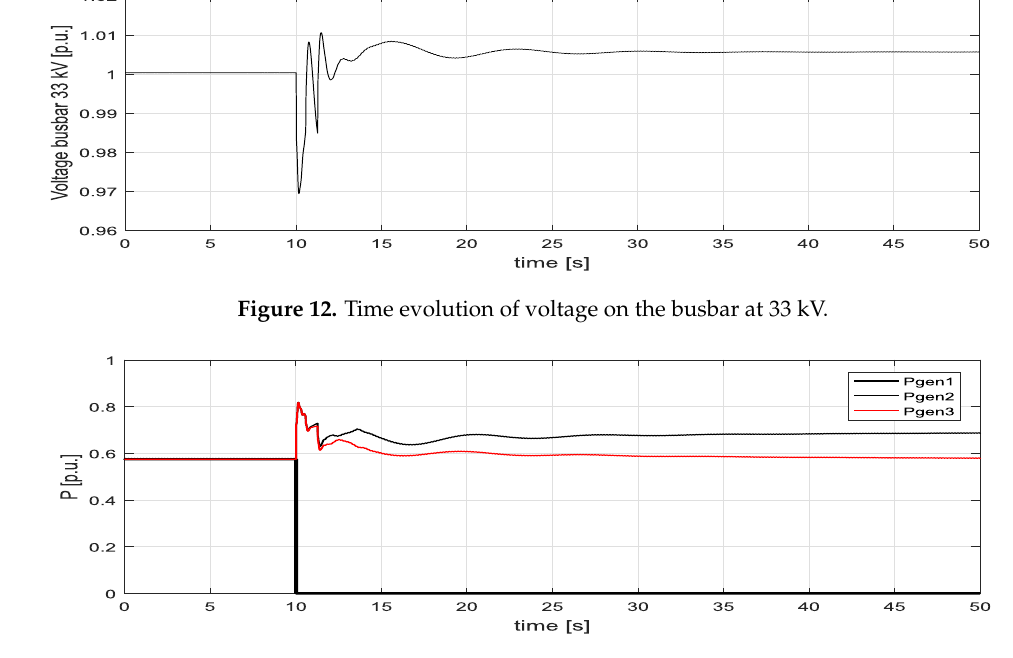
Figure 13. Time evolution of the active powers (Pgen) of the three